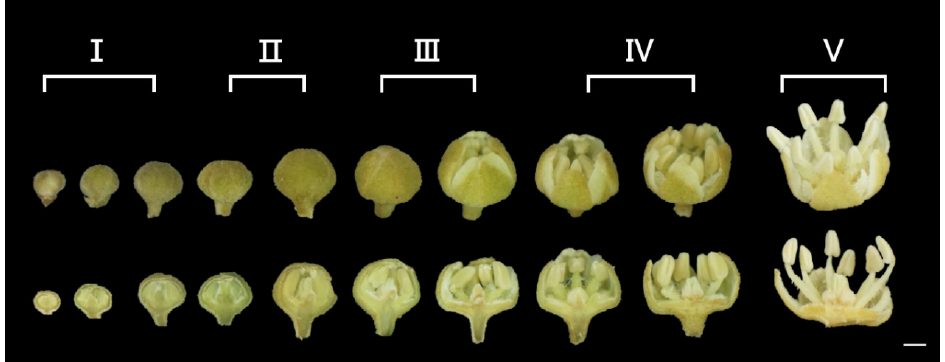
Figure 3. Morphological characteristics of male flower buds at different developmental stages of ‘Shixia’. ( I ) The male flower buds were light green, with a diameter of 1.4–2.0 mm, sepals completely closed, and stamens and pistils clearly visible. ( II ) The male flower buds were brown-green, with a diameter of 2.1–3.0 mm, sepals closed, and stamens and pistils equal in height. ( III ) The male flower buds were yellow-green, with a diameter of 3.1–3.8 mm, sepals slightly open, and stamens higher than (atrophic) pistils. ( IV ) The male flower buds are light yellow, with a diameter of 3.9–4.4 mm and sepals open to reveal the stamens. ( V ) The male flowers were yellow and blooming, with a diameter of over 4.4 mm and sepals fully spreading. Scale bar = 1 mm.